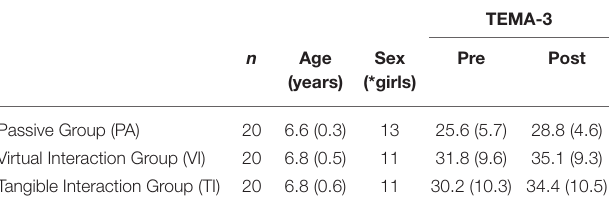
TABLE 1 | Mean and standard deviations at pre- and post-tests by